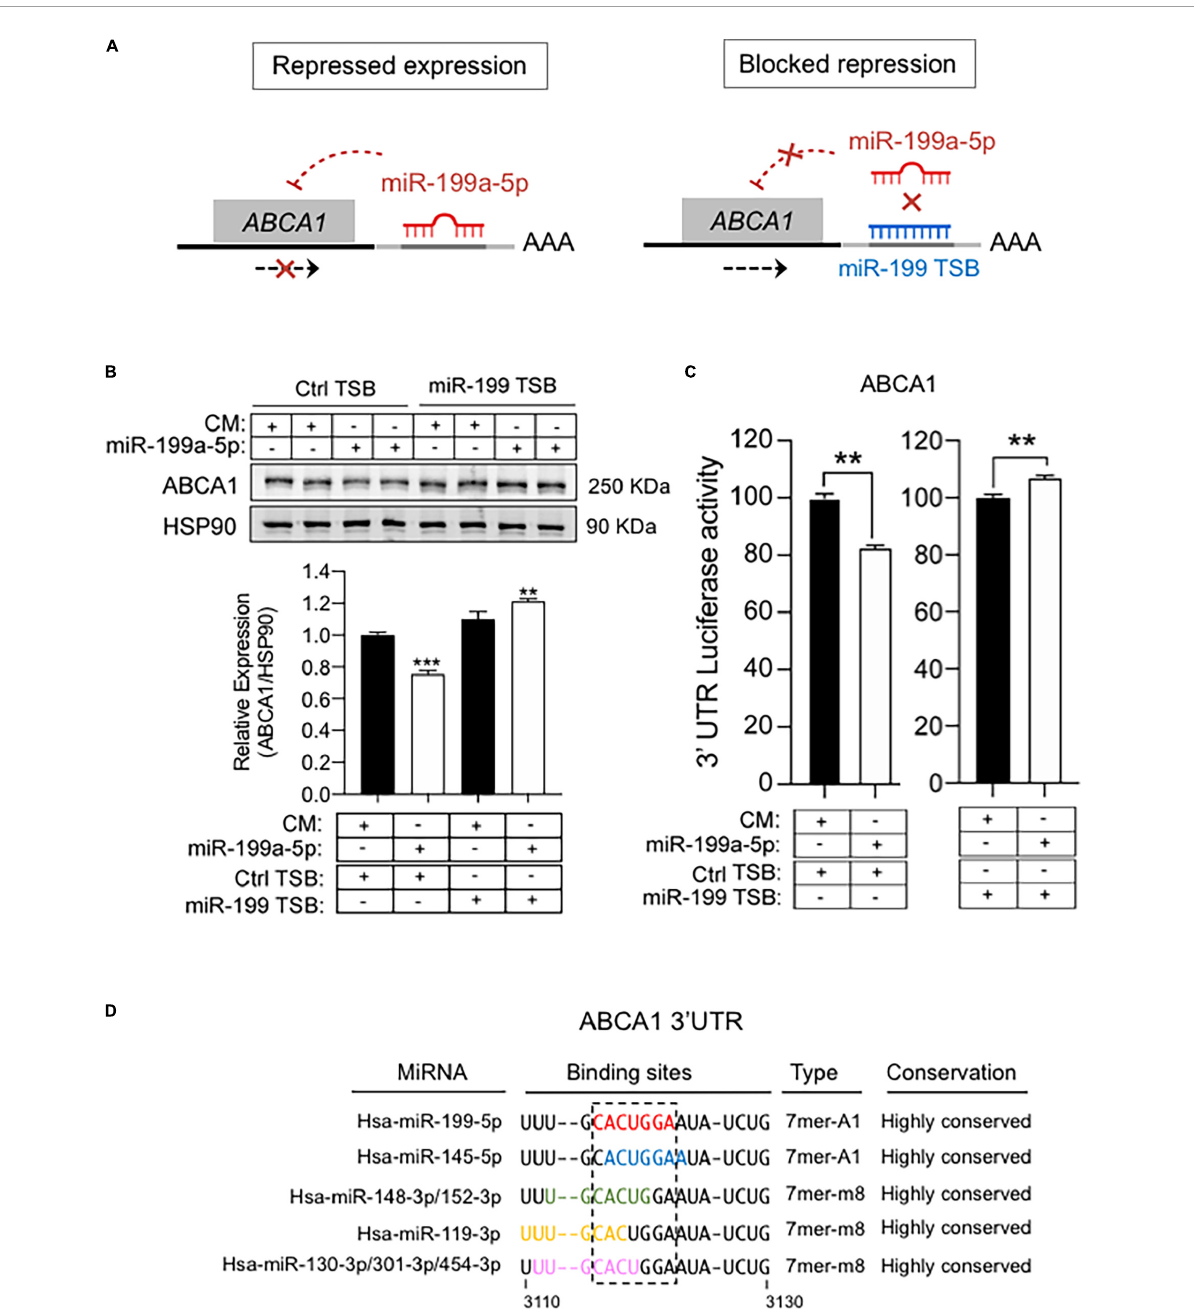
FIGURE7 MiR-199 target site blockers and ABCA1 expression. (A) Schematic overview of LNA-enhanced target site blocker (TSB) mode of action. Without miR-199 TSB or with scramble TSB, miR-199/RISC complex binds to the 3’UTR of ABCA1 mRNA, thereby attenuating its expression. By contrast, addition of miR-199 TSB blocks the binding of miR-199 and derepress ABCA1. (B) Representative Western blot of ABCA1 in mouse peritoneal macrophages transfected as indicated. transfected with synthetic miR-199a-5p mimic in the presence of scramble TSBs or specific miR-199 TSBs for 48 h. Lower panel shows relative ABCA1 protein expression normalized to HSP90 ( n = 6). *P < 0.05, significantly different from cells cotransfected with CM and Ctrl TSB. (C) Luciferase reporter activity in COS-7 cells transfected with CM or miR-199a-5p mimic and the ABCA1 3’UTR in the presence of Ctrl TSB or miR-199a-5p TSB. Data are expressed as relative luciferase and correspond to the means ± SEM of three experiments performed in triplicate. **P < 0.01, significantly different from cells transfected with CM (left panel) or Ctrl TSB (right panel) ***P > 0.001. (D) Representation of the human 3’UTR region of ABCA1 where miR-199-5p binding site is located (red), and the overlapping with binding sites for the indicated